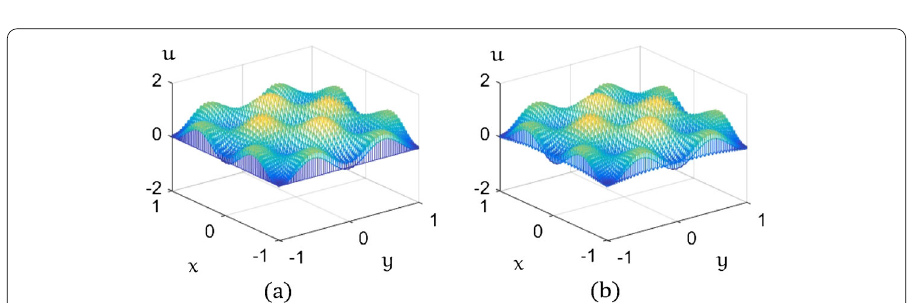
Figure 3 ( a ) The genuine solution when t = 0.6. ( b ) The CNFE solution when t = 0.6